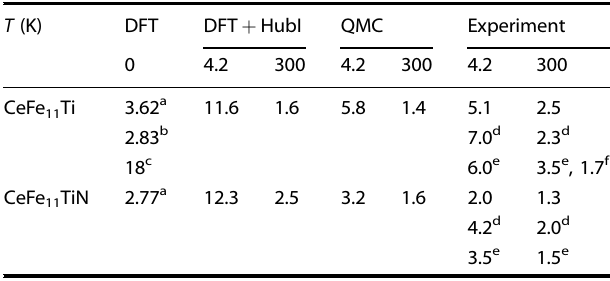
Table 2. Anisotropy fi eld H A